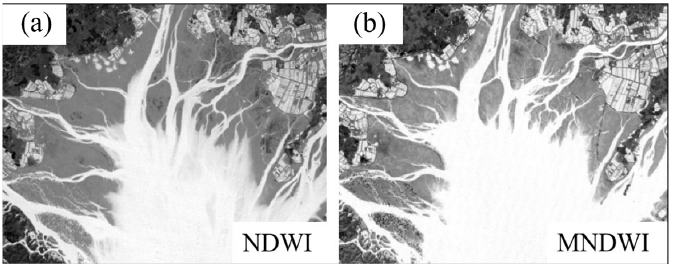
Figure 2. Comparison of calculation results of NDWI and MNDWI . ( a ) NDWI of water bodies ; ( b ) MNDWI of water bodies.